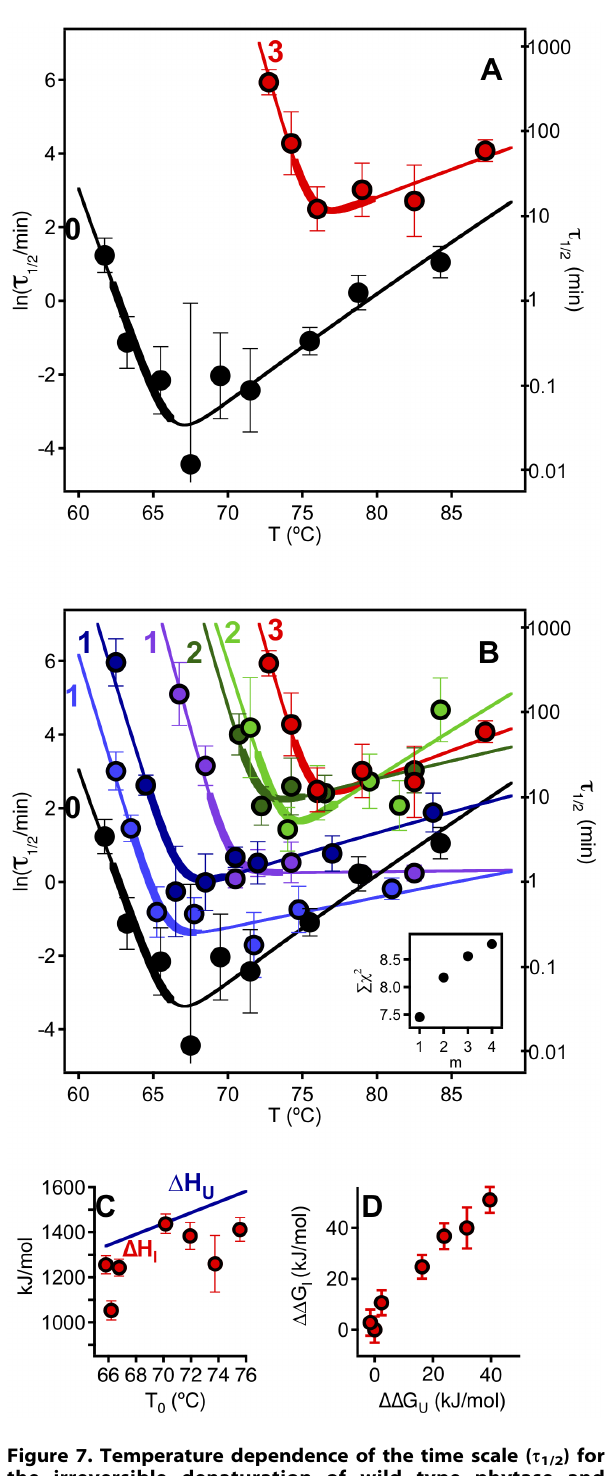
Figure 7. Temperature dependence of the time scale ( t 1/2 ) for the irreversible denaturation of wild type phytase and variants. (A) and (B) Plots of ln( t 1/2 ) versus temperature for the variants (for the sake of clarity, only wild type and the variant with three engineered bridges are included in panel A). The continuous lines represent the best fits of equation 3 and the Inset in panel B is a plot of a measure of goodness of fit ( x 2 ) versus the reaction order m in equation 3 (see main text and Text S2 for details). Thicker lines indicate the temperature range of denaturation transition as seen by DSC (Figure 5A). The colors of the lines and data points refer to the variant, as specified in panel A of Figure 5, with the number of